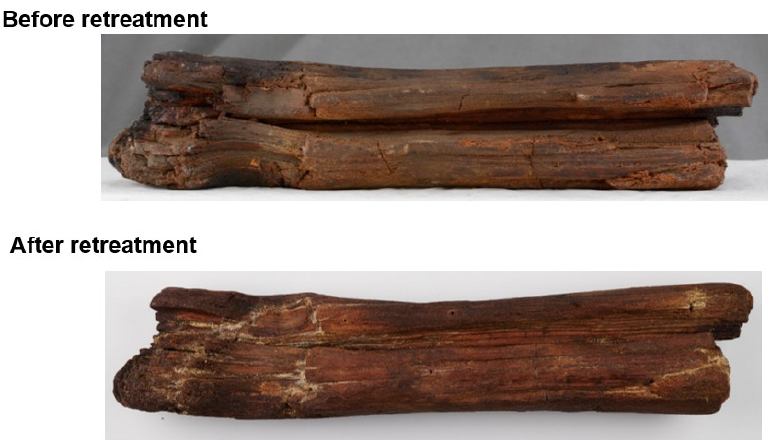
Figure 2. Wood fragment from the Oseberg collection before and after retreatment by injection with siloxane PS36000 in turpentine at a concentration of ~5% (50 g/L). The fragment had been originally treated with alum and linseed oil shortly after excavation in 1904.